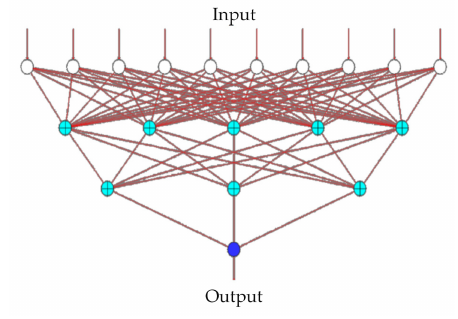
Figure 2. Network design architecture diagram.